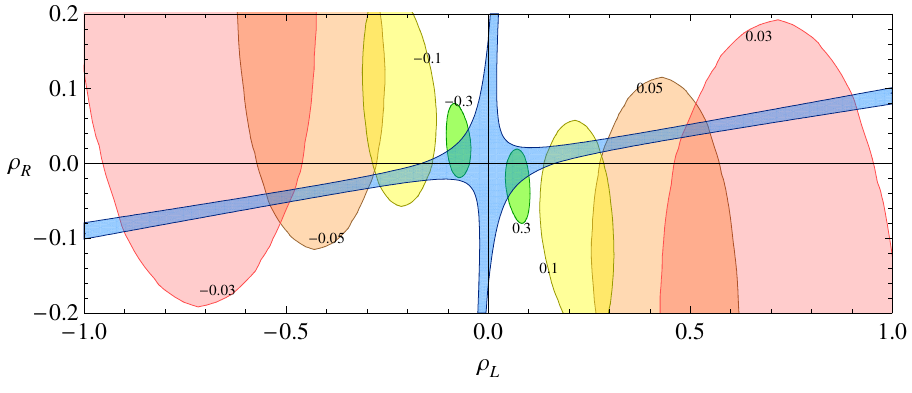
versus (cid:26) for m = 1 TeV which are consistent with the C np R L Z 0 = (cid:6) 0 : 03 (red), (cid:6) 0 : 05 (orange), (cid:6) 0 : 1 (yellow), and (cid:6) 0 : 3 V